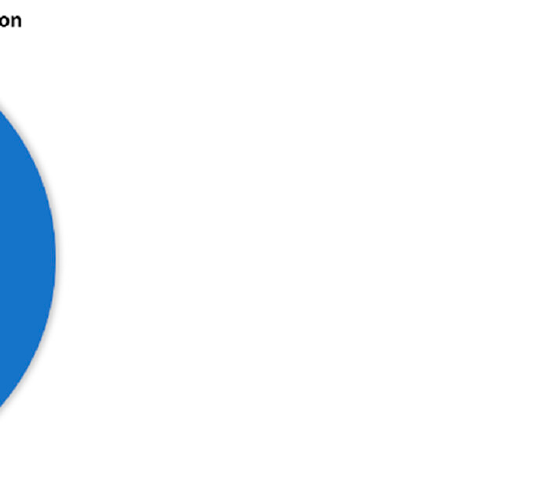
Figure 5. Representation of the use of different gases for pore structure analysis in the selected literature. (Elaborated from analysis of articles in the attached Excel file).